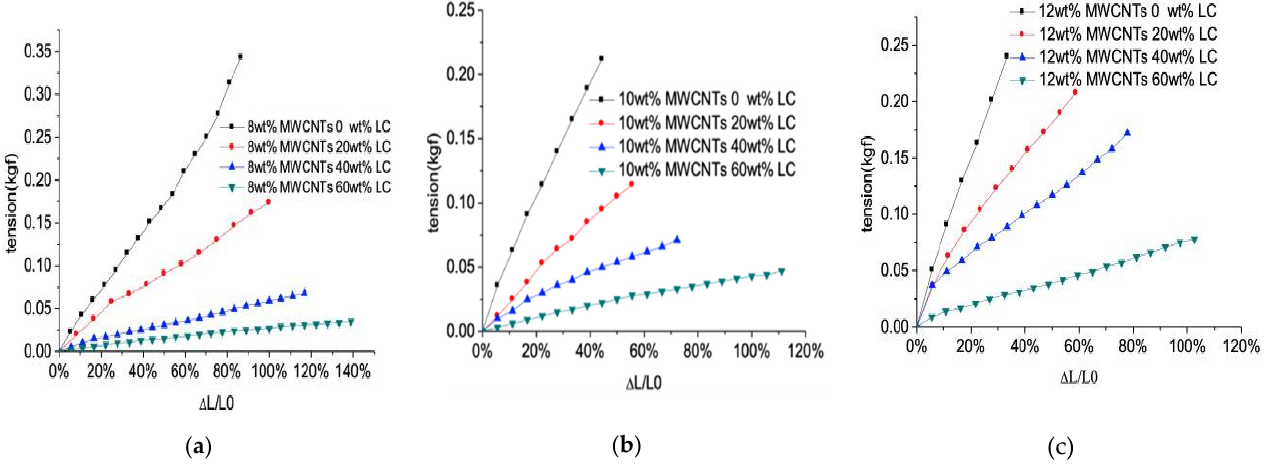
Figure 4. The strain of the tensile sensor with concentration of MWCNT of ( a ) 8 wt%; ( b ) 10 wt%; and ( c ) 12 wt%. According to the fitting curve shown in Figure 5, the slope of the curve indicates the measurement of the flexible strain sensor’s sensitivity which is termed as a gauge factor (GF). The sensitivity decreases from 6.97 to 2.74 when the MWCNTs’ concentration raises from 8 wt% to 12 wt% without LC. When the LC’s concentration increases from 0 wt% to 60 wt%, all the sensors’ sensitivity decreases at first and then increases. The least square method of the curve fitting shows the linearity of the sensor. When the concentration of the MWCNTs is 8 wt%, the sensor’s linearity decreases as the LC’s concentration increases. When the LC’s concentration changes to 60 wt%, the resistance response curve shows two linear segments, the sensitivity of the GF, 10.9, with low tensile force of 0–60% strain and the sensitivity of the GF, 40, with high tensile force of 60–100% strain, as shown in Figure 6. When the concentration of MWCNTs is high, 12 wt%, the sensor shows a good linearity with different LC concentration. When the LC concentration increases to 60 wt%, the sensitivity is higher than that without LC and the stretchability is almost 2.5 times of the sensor without LC. The introduction of LC improves the agglomeration of MWCNTs and forms the porous conductive polymer with LC droplets, which extends the range of the resistance of the tension sensor and improves the flexible sensor’s sensitivity.